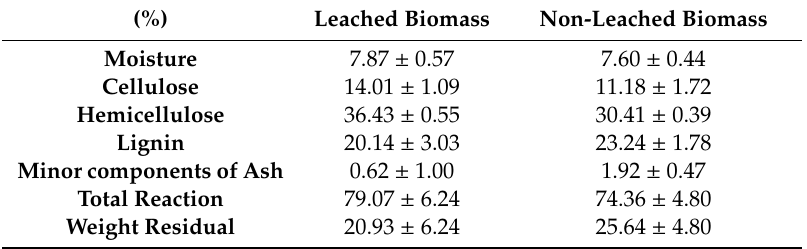
Table 4. Relative percentages of each pseudo-component for both